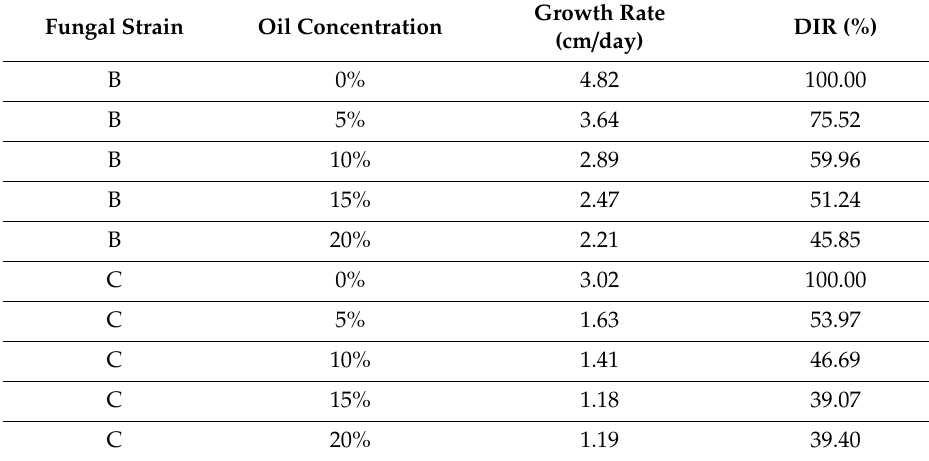
Table 2. Hydrocarbon tolerance and dose inhibition by two selected fungal strains from crude oil polluted